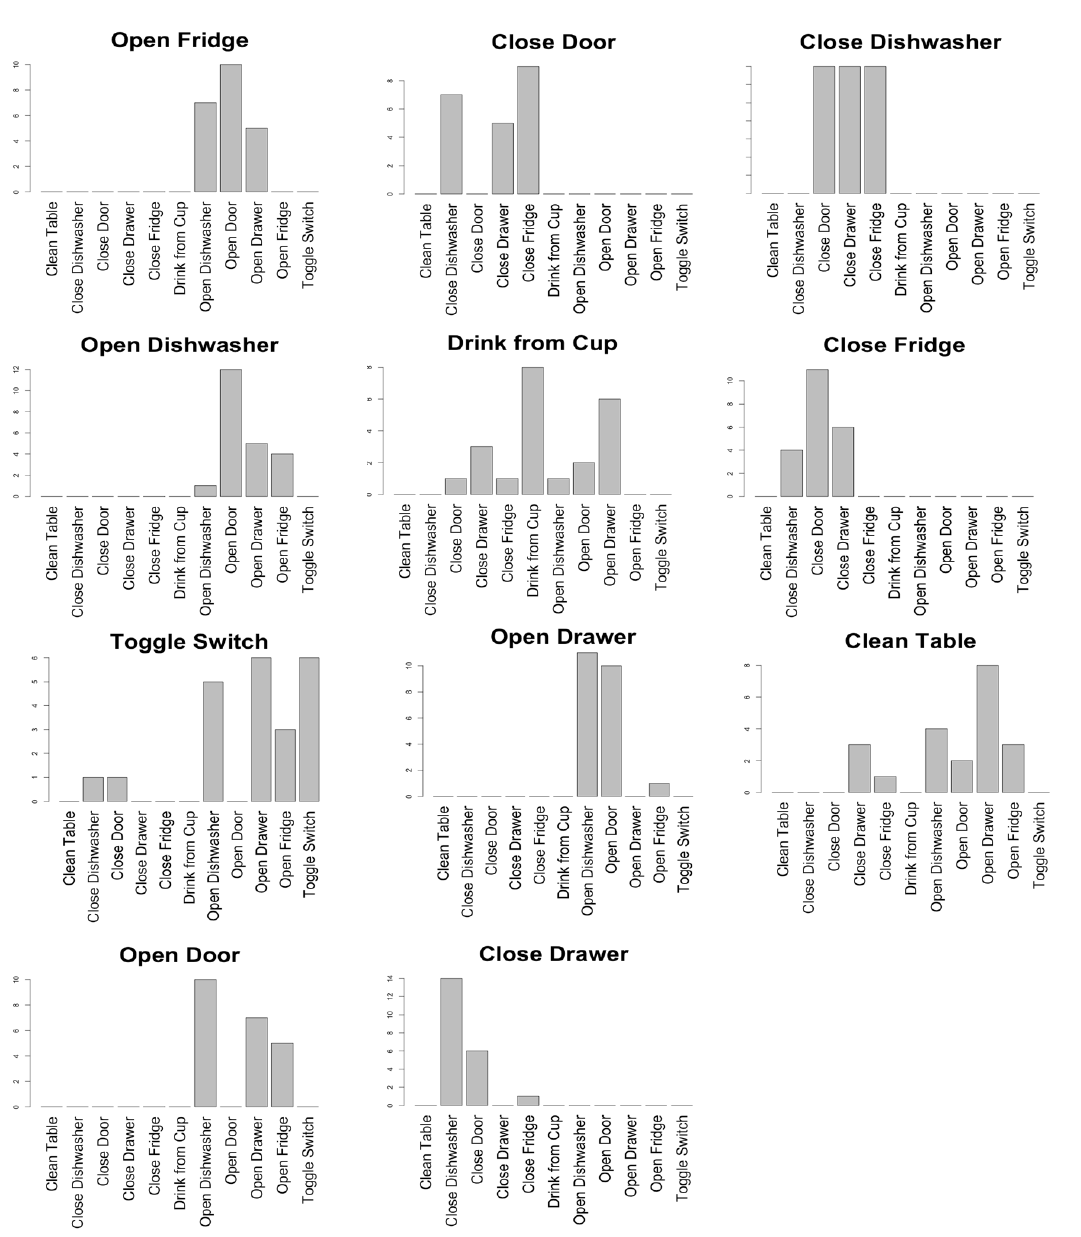
Figure A2. Result of the histogram of the nearest classes appearing in OPP data for each samples set for the word embedding area